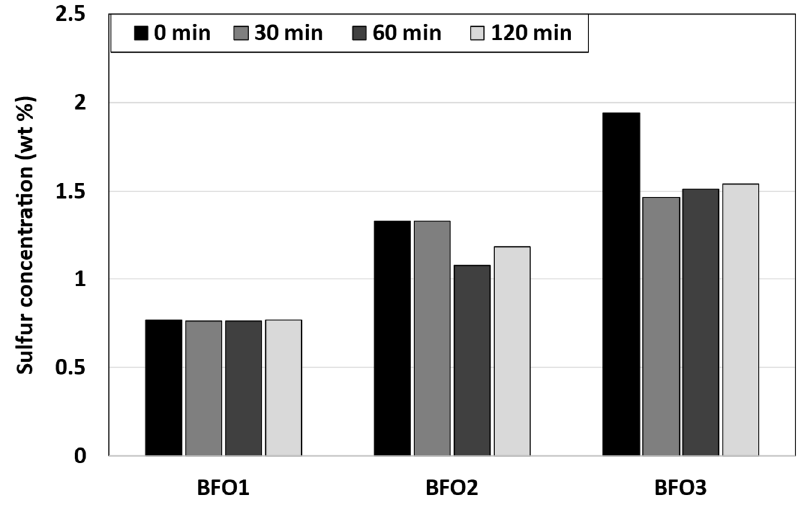
Figure 6. Variation in sulfur concentration with ultrasonic irradiation time.